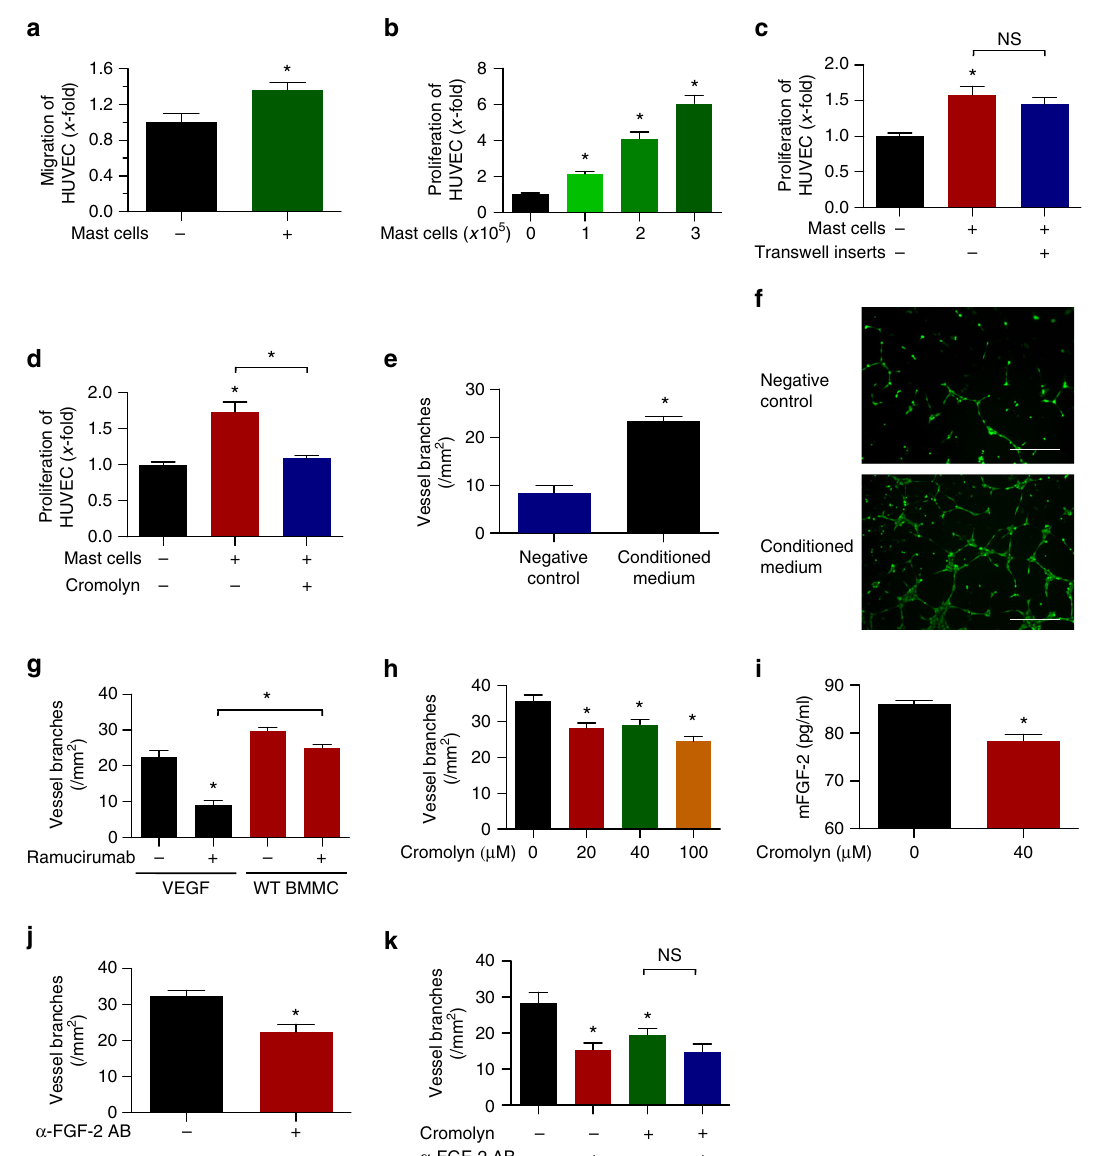
Fig. 5 Mast cells secrete pro-angiogenic factors that alter the proliferative and organizational state of endothelial cells. a Transwell migration assay of HUVEC stimulated with MC-conditioned medium ( n = 3; * p < 0.05; two-tailed t -test). b Direct co-culture of HUVEC and BMMC ( n = 11 – 12; * p < 0.05; one- way ANOVA). c Indirect co-culture of HUVEC and BMMC ( n = 3; * p < 0.05; one-way ANOVA). d HUVEC were cultured in the presence of MC – conditioned medium ( n = 3; * p < 0.05; one-way ANOVA). e Tube formation assays of HUVEC in the presence of serum free or MC-conditioned medium ( n = 3 – 4; * p < 0.05; two-tailed t -test). f Representative pictures of tube formation assays with scale bars representing 400 µ m. g Tube formation of HUVEC in response to ramucirumab. VEGFA or conditioned medium from WT BMMC was used as stimulus ( n = 7 – 10; * p < 0.05; one-way ANOVA). h BMMC-induced tube formation of HUVEC response to different concentrations of cromolyn ( n = 3; * p < 0.05; one-way ANOVA). i Secretion of MC- derived FGF-2 in response to 40 µ M cromolyn ( n = 2; * p < 0.05; two-tailed t -test). j BMMC-induced tube formation of HUVEC in response to 0.5 µ g/ml anti-FGF-2 antibody ( n = 8; * p < 0.05; two-tailed t -test). k BMMC-induced tube formation of HUVEC in response to single or combinatorial treatment